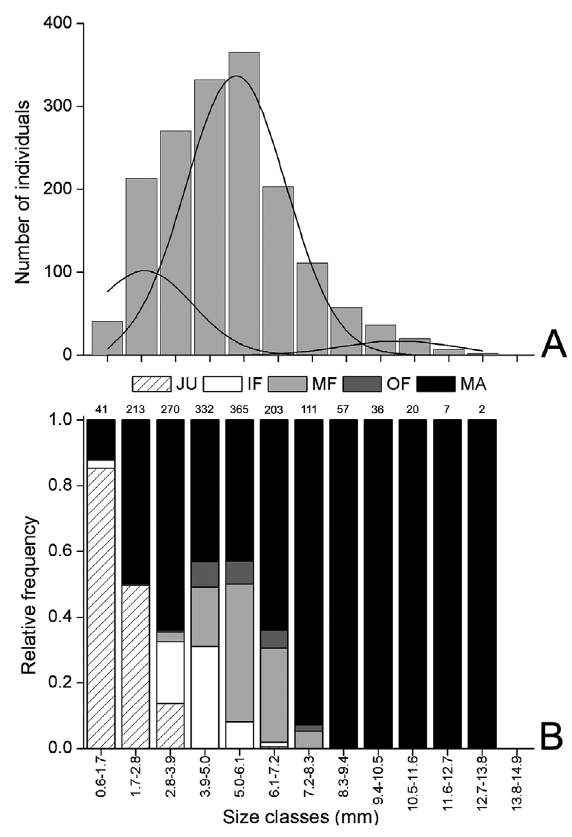
Fig. 4. – Population distribution of Caprella scaura in the Ubatuba region, southeastern Brazil. A, observed population distribution of the individuals collected in this study; B, relative frequency of the individuals by size classes (mm) and demographic categories. JU, juveniles; IF, immature females; MF, mature females; OF, ovigerous females; MA, males.